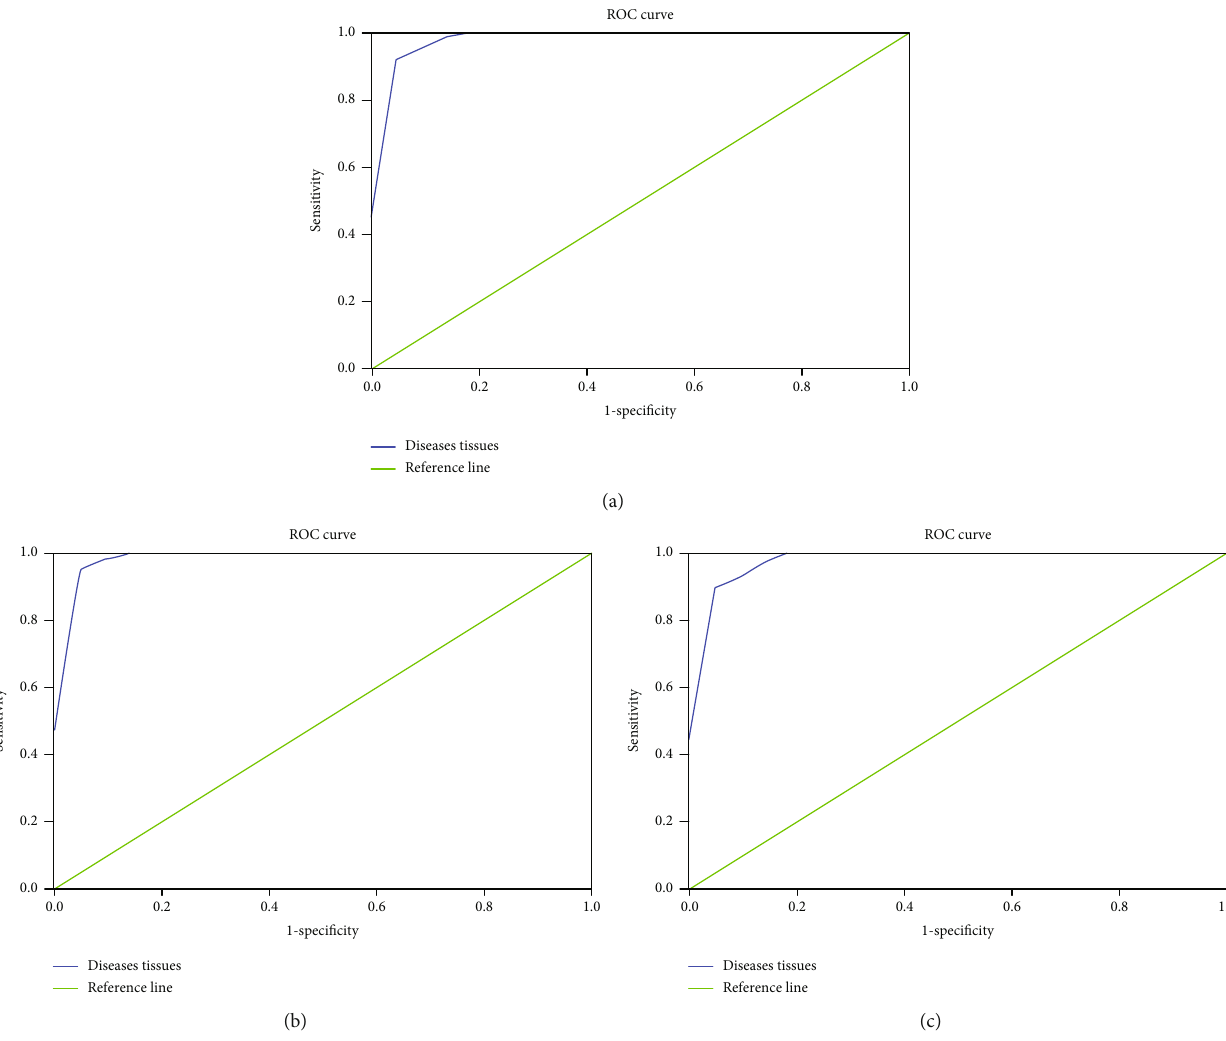
Figure 7: The ROC curves of (a) the integral energy ratio in the noncontinuous frequency band, (b) the integral energy ratio in the continuous frequency band, and (c) the peak intensity ratio of I1560 cm -1 /I1103 cm -1